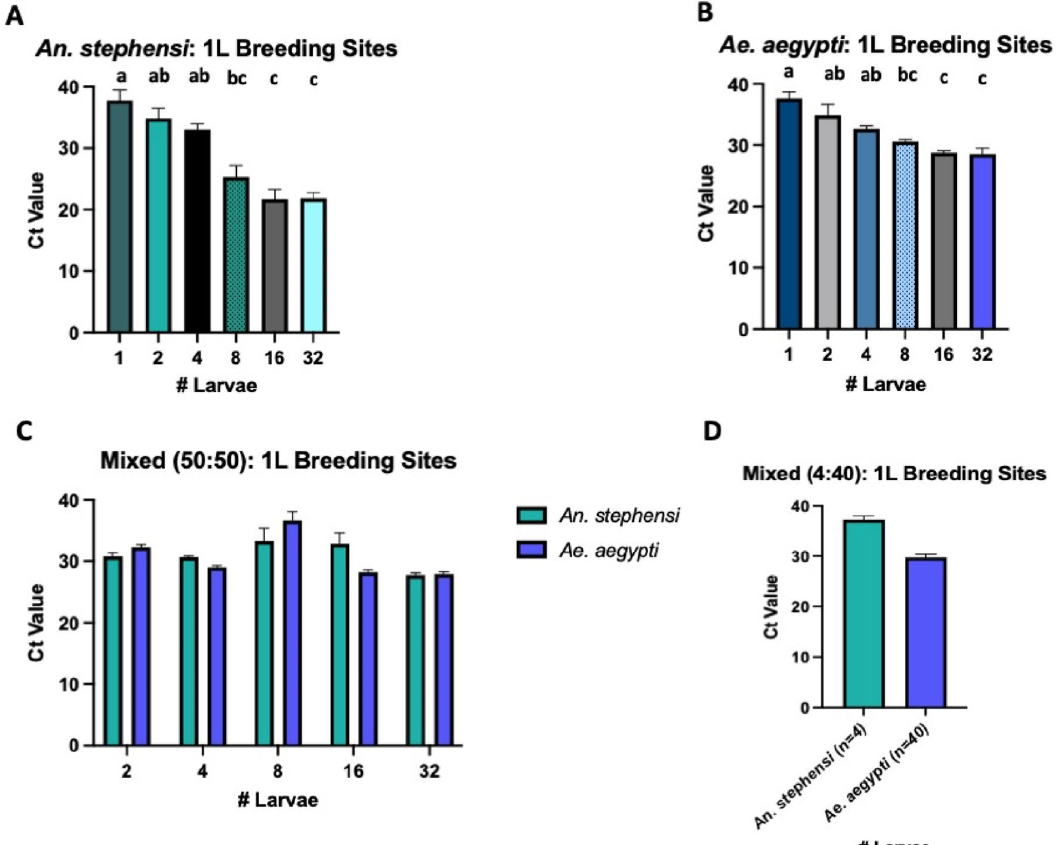
Figure 3. Taqman qPCR detection of An. stephensi ( A ), Ae. aegypti ( B ) or both species in equal ( C ) or 4:40 ( D ) proportions from 1L breeding sites. qPCR detection for all extractions were run in technical triplicate. Conditions sharing a superscript do not differ significantly (Dunn’s multiple comparisons test, p > 0.05). Error bars indicate 95% confidence intervals